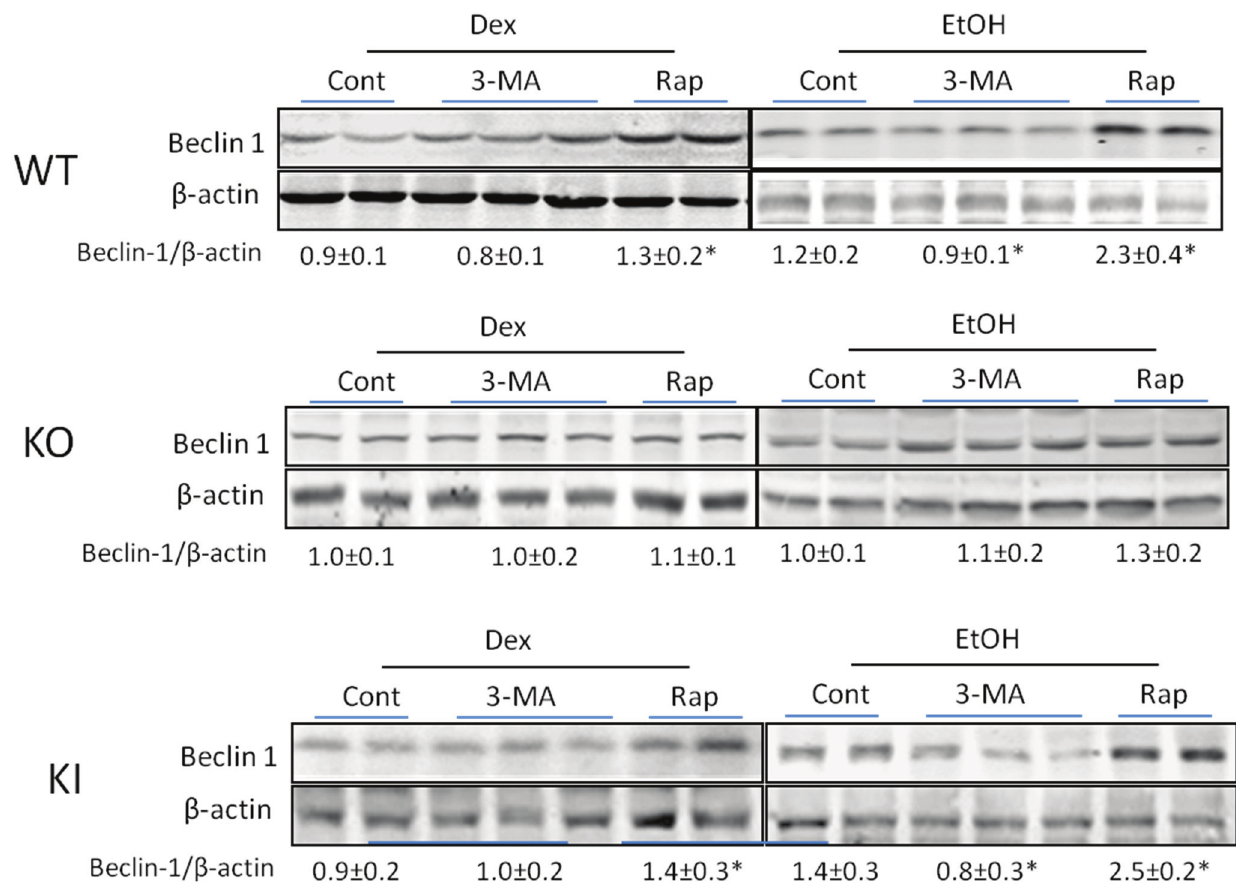
Figure 5. Effect of chronic ethanol or ethanol plus 3-MA or rapamycin on levels of Beclin-1. Beclin-1 levels in WT, KO and KI mice fed with alcohol or dextrose with or without 3-MA or rapamycin administration were determined by immunoblots. *, p < 0.05 compared with alcohol-alone fed or dextrose-alone fed mice. Results are calculated from four mice in each group, N = 4, although two to three blots are actually